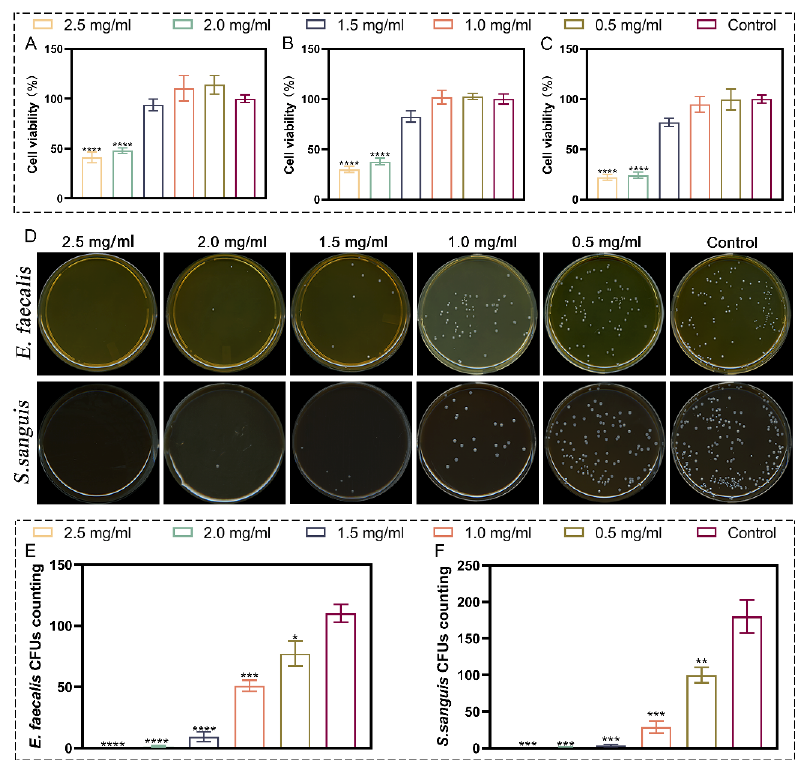
Figure 2. In vitro cytocompatibility test and CFU count test. ( A – C ) CCK-8 assay of L929 cells on days 1–3. ( D ) Typical photographs of E. faecalis and S. sanguis bacterial colonies after cocultivation with hydrogel samples containing different concentrations of Fe 3 O 4 -CaO 2 NPs. ( E , F ) Statistical results related to the bacterial colony numbers of E. faecalis and S. sanguis . * p < 0.05, ** p < 0.01, *** p < 0.001, and **** p <